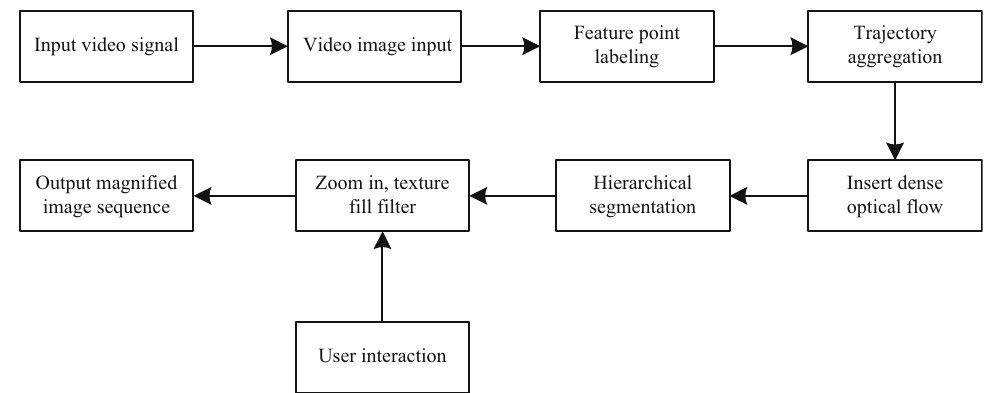
Figure 5: Image detail enhancement region enlargement processing.